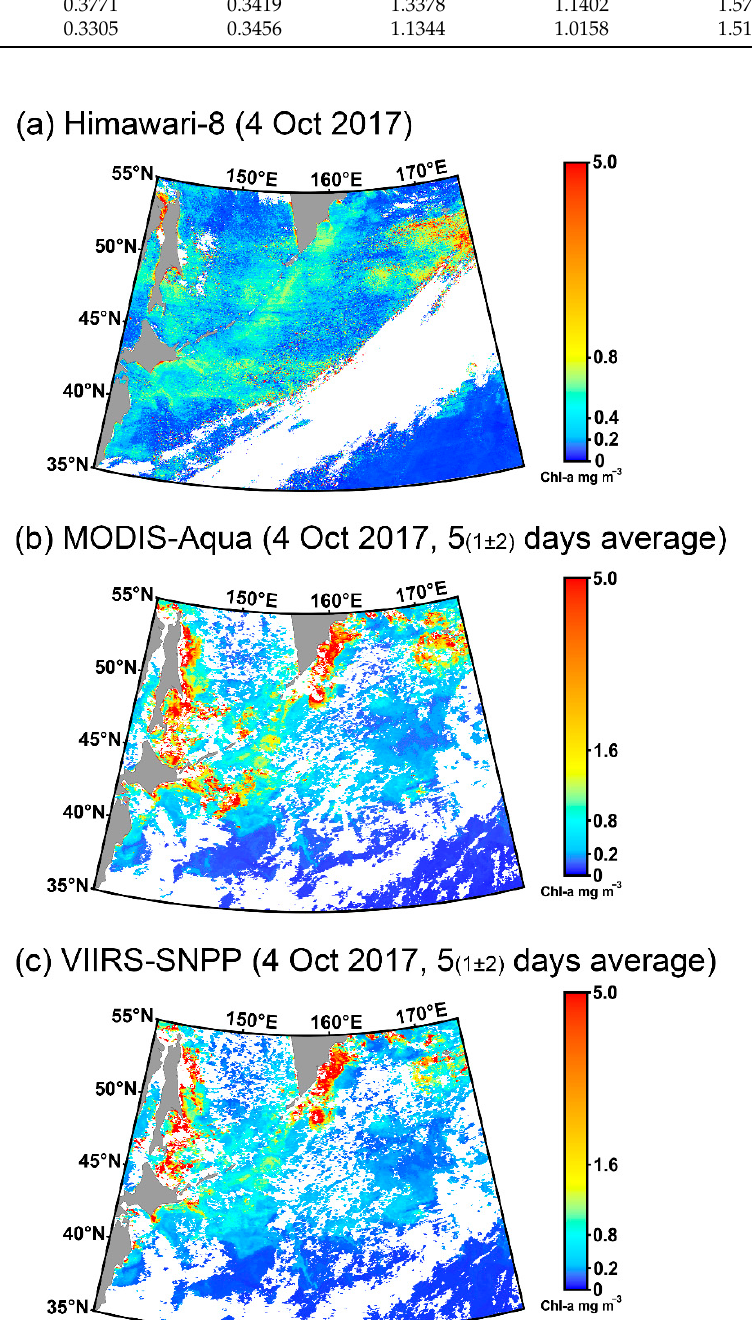
Figure 9. Sample images of the blending algorithms. Figures ( a – c ) correspond to Himawari-8, MODIS-Aqua, and VIIRS-SNPP, respectively.